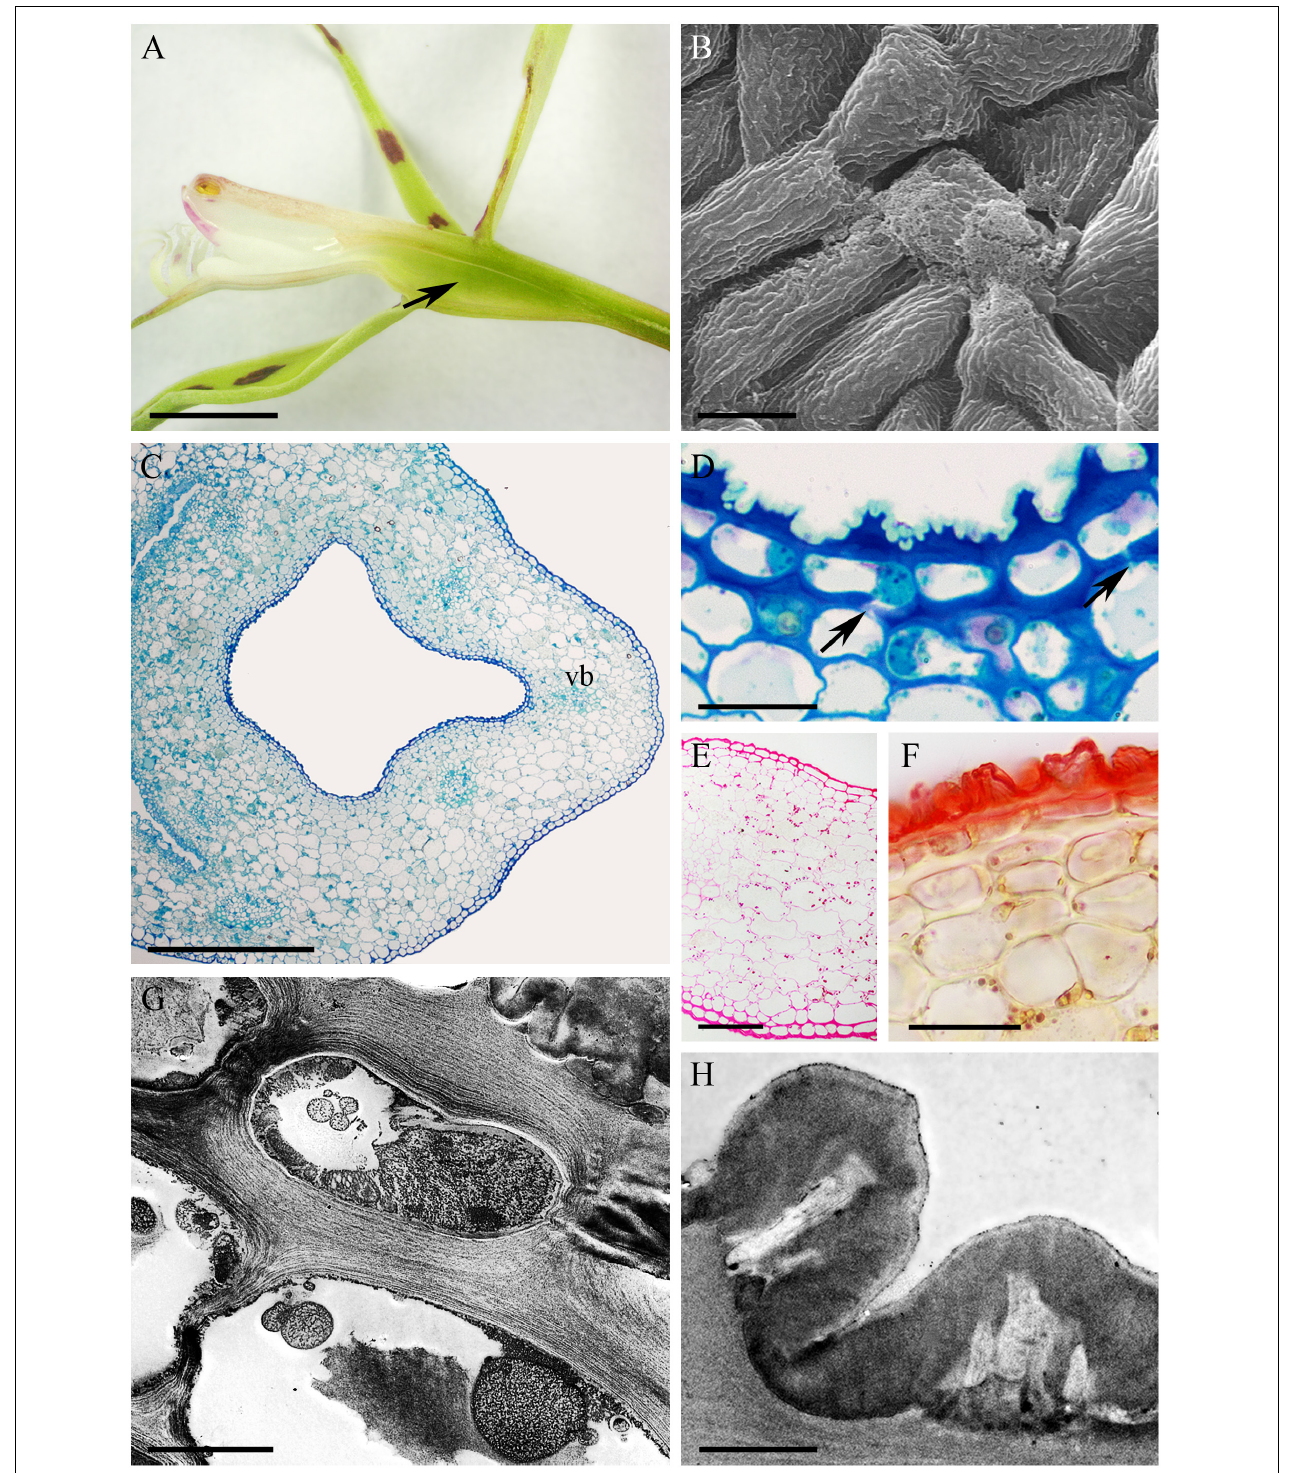
FIGURE 8 | Epidendrum criniferum . (A) Longitudinal section of flower, the expanded part of the cuniculus indicated by arrow. (B) Surface secretion on cuticle. (C) Transverse section of ovary showing cuniculus and surrounding tissues (MB/AII). (D) Epidermis and subepidermal parenchyma with primary pit-fields (arrows). Cellulosic projections of cell wall with overlying cuticle (MB/AII). (E) PAS reaction shows starch in subepidermal parenchyma. (F) Thick cuticle stained with Sudan III. (G) Epidermal and subepidermal cells with intravacuolar, globular material. (H) Convoluted cuticle with cellulosic projections of cell wall. Scale bars: A = 4 mm; B = 50 µ m; C = 500 µ m; D = 20 µ m; E = 100 µ m; F = 30 µ m; G = 5 µ m; H = 2 µ m.